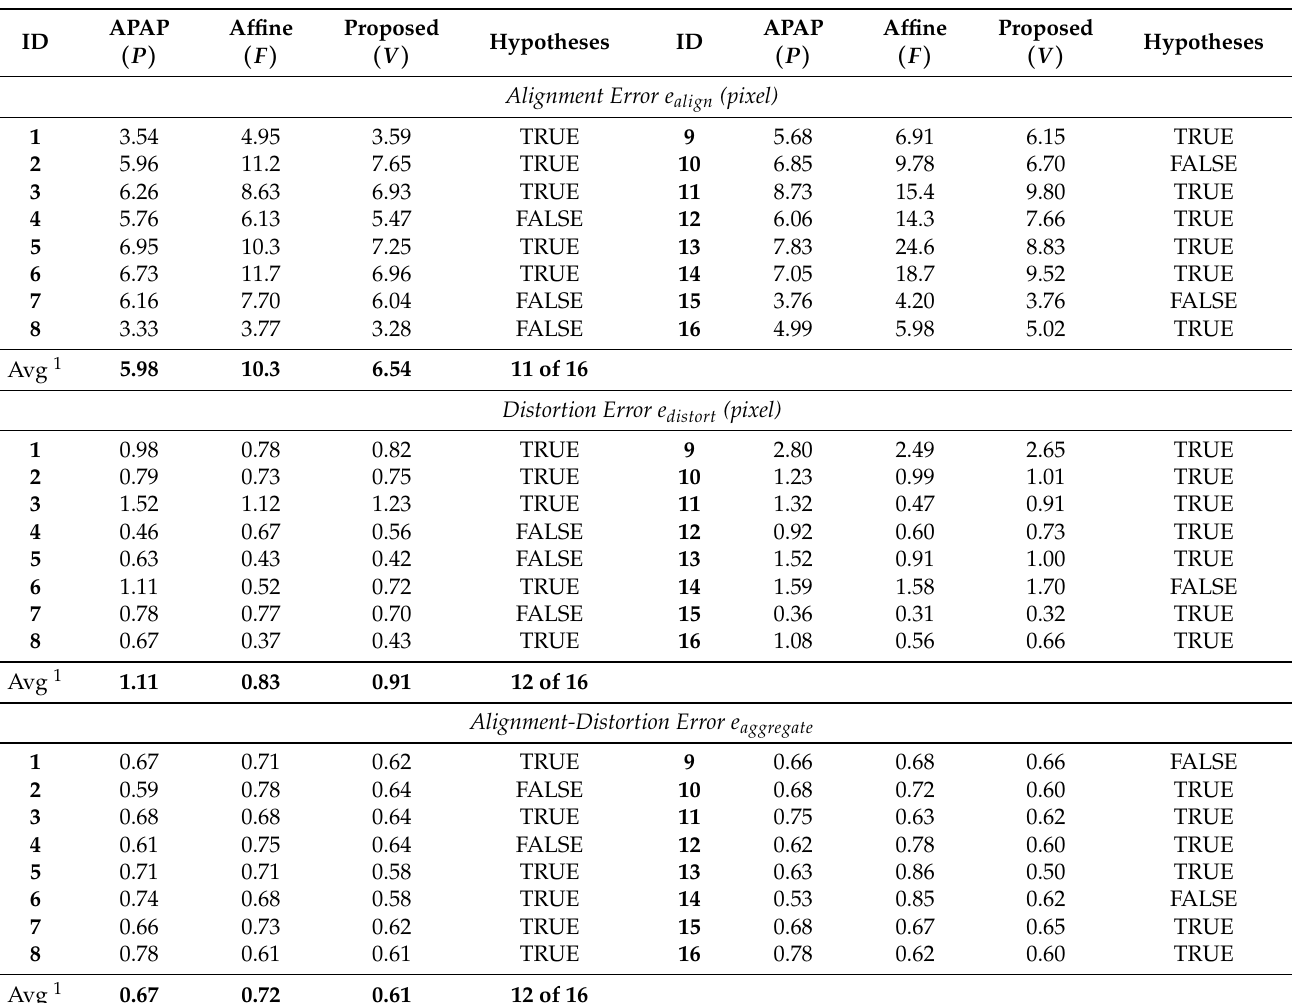
Table 3. Results for the image alignment step between the ROI tangent image (ROI-TI) with the high-resolution planar image (HPI). We compared the image alignment step output of the Proposed ( V ) approach with existing Affine ( F ) and APAP ( P ) approaches. Most of results follow the alignment error hypotheses e align ( F ) > e align ( V ) > e align ( P ) (11